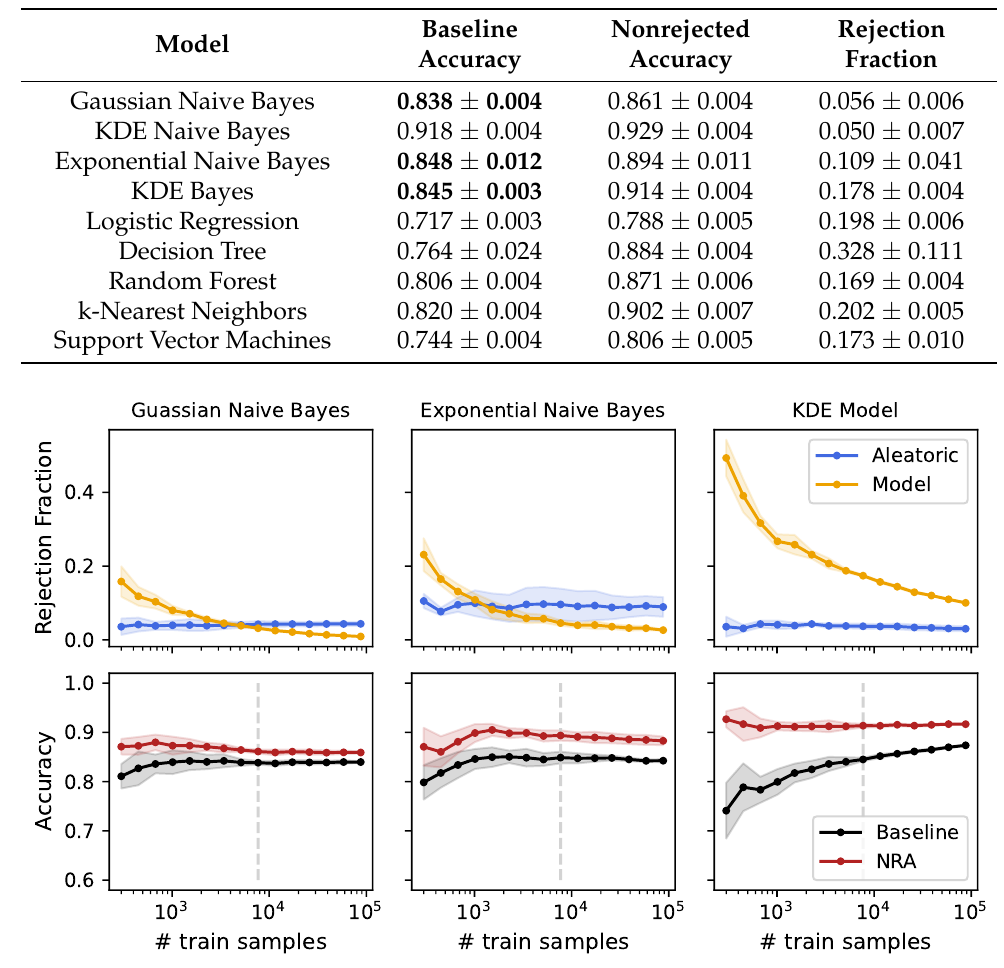
Figure 4. Uncertainties’ rejection fraction and obtained accuracies using a k-fold cross-validation with an increasing number of training samples for 3 different models. The vertical line represents a training size that obtained a similar baseline accuracy for all